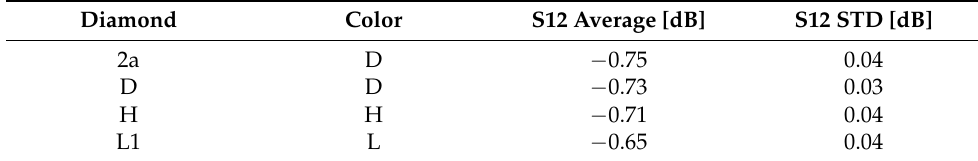
Table 2. Average and STD of S12 at a frequency of 17.72 GHz for the master diamonds. Diamond